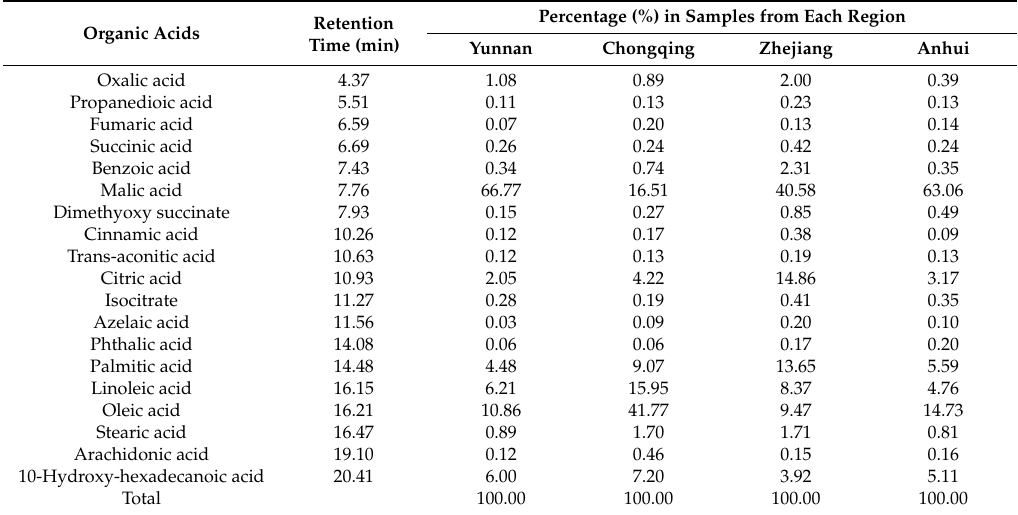
Table 2. Proportion of organic acids in the dried fruits of C. speciosa from four production areas. Percentage (%) in Samples from Each Region Organic Acids Retention Time (min) Yunnan Chongqing Zhejiang Anhui